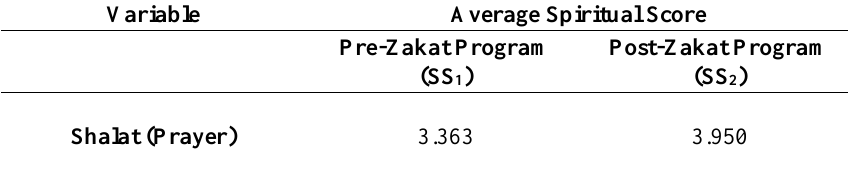
Table 3 Average Spiritual Score of the Mustahik Households